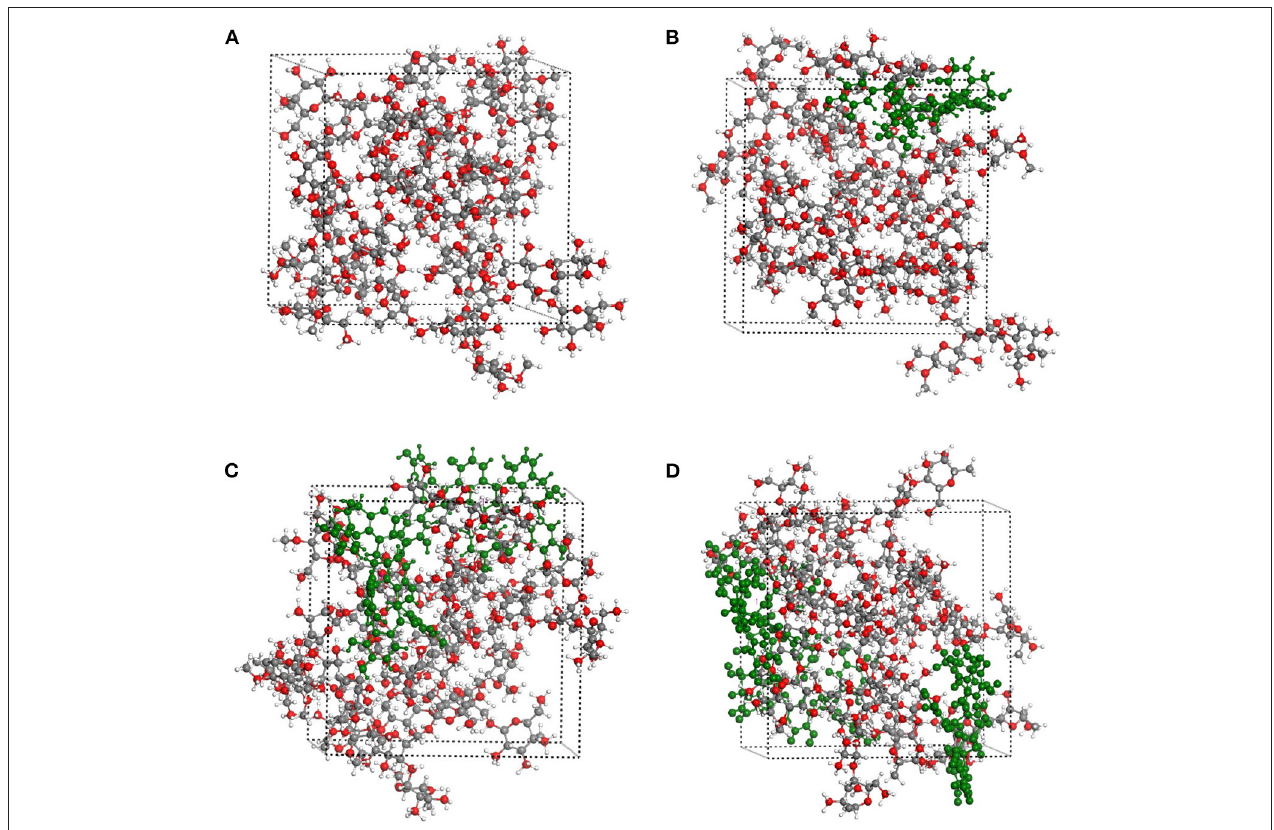
FIGURE 6 | Simulation systems of molecule of RS with or without LSOPC, 0PC S (A) , 1PC S (B) , 2PC S (C) , and 3PC S (D)